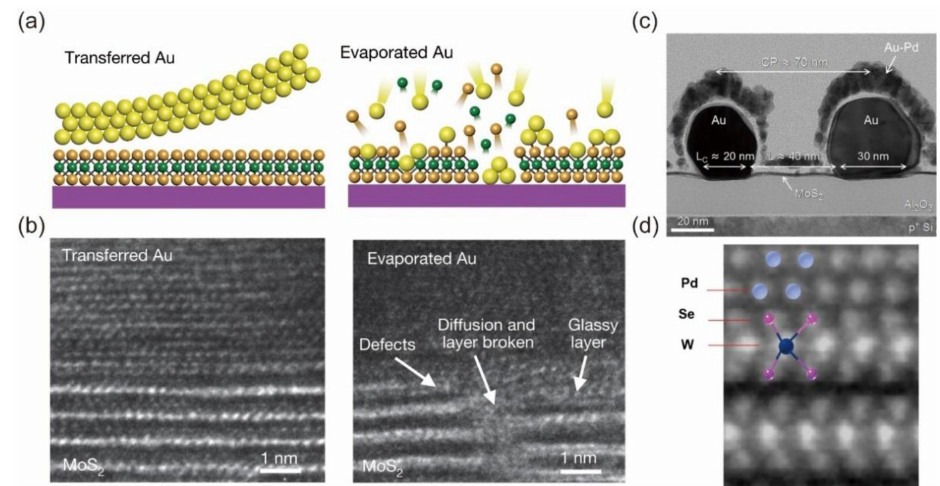
Figure 2. Atomical clean interface is significant to Fermi-level depinning. ( a ) cross-sectional schemat- ics of transferred Au electrodes with atomically sharp and clean metal–semiconductor interfaces and conventional electron beam-deposited Au electrodes with poor interface. ( b ) Cross-section TEM images of transferred Au electrodes and evaporated Au electrodes. Reprinted/adapted with permission from Ref. [13]. Copyright 2018, Springer Nature. ( c ) TEM cross-section of a MoS 2 FET with gold electrodes deposited under ultra-high vacuum. Reproduced with permission from Ref. [35]. Copyright 2016, American Chemical Society. ( d ) cross-sectional STEM of the Pd–WSe 2 interface. Reprinted/adapted with permission from Ref. [8]. Copyright 2022, Springer